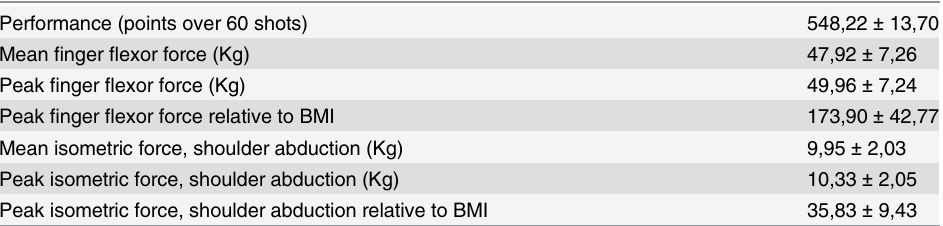
Table 2. Mean ( ± s) of the recorded data. N = 46.